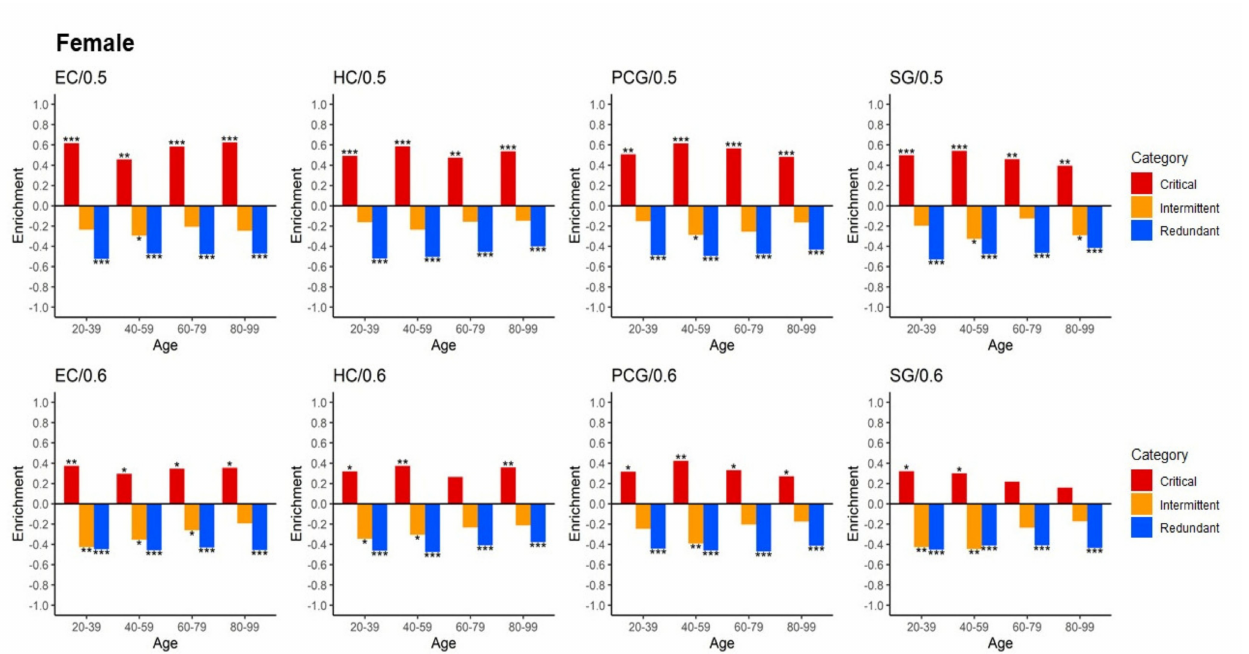
Figure 6. Enrichment values for the association of proteins with well-known ageing genes vs. each age period and each control category. Female samples for all four brain regions at three values of threshold probability Θ . See Supplemen- tary Information file for the male samples. The following symbols *** denote p -value < 0.001, ** ( p -value < 0.01), and * ( p -value < 0.05). Negative enrichment indicates